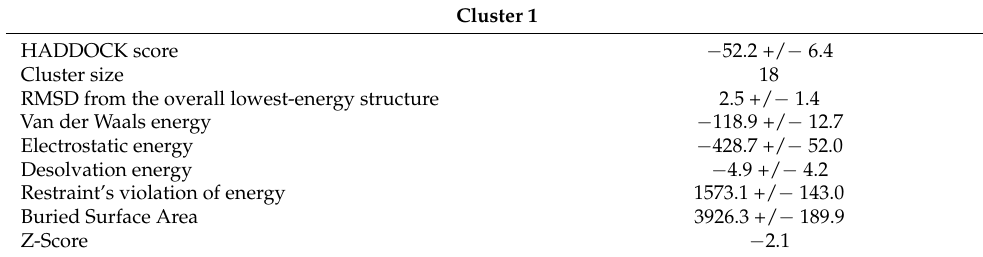
Figure 8. The docked complex between the designed vaccine constructs and the TLR2 receptor. Vaccine, the surface is represented in cyan, while the TLR-2 receptor is represented in green. Table 5. Protein–protein docking results between TLR-2 and vaccine